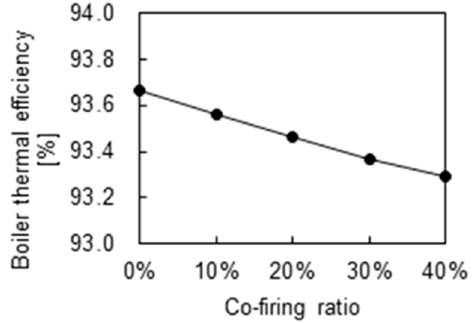
Figure 8. Effect of ammonia co-firing on boiler thermal efficiency.